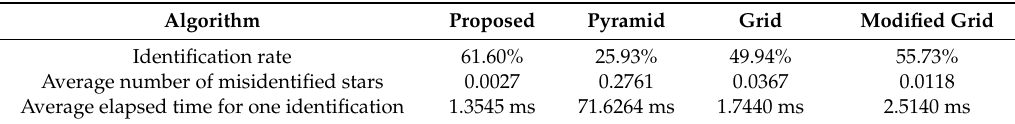
Table 7. Case 1: Comparing results of star identification methods at 150 arc-seconds position